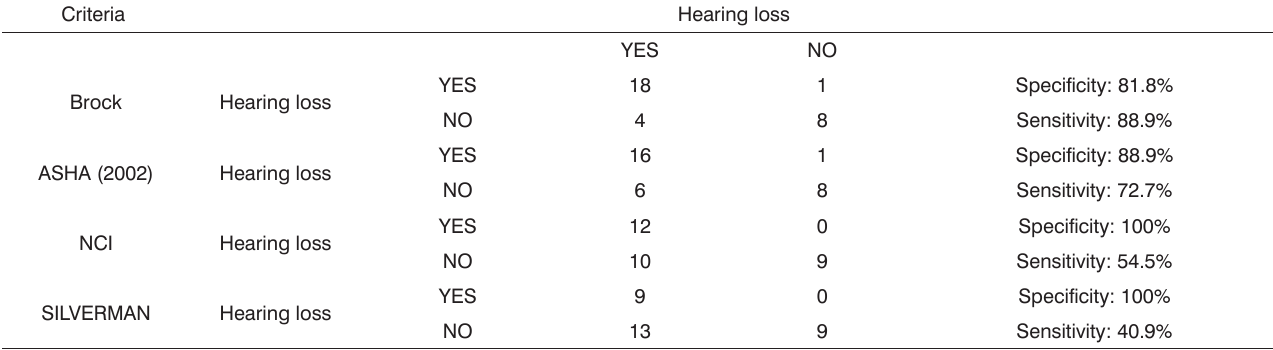
Table 2. Sensitivity and Specificity, with their respective confidence intervals (CI), for each criterion.